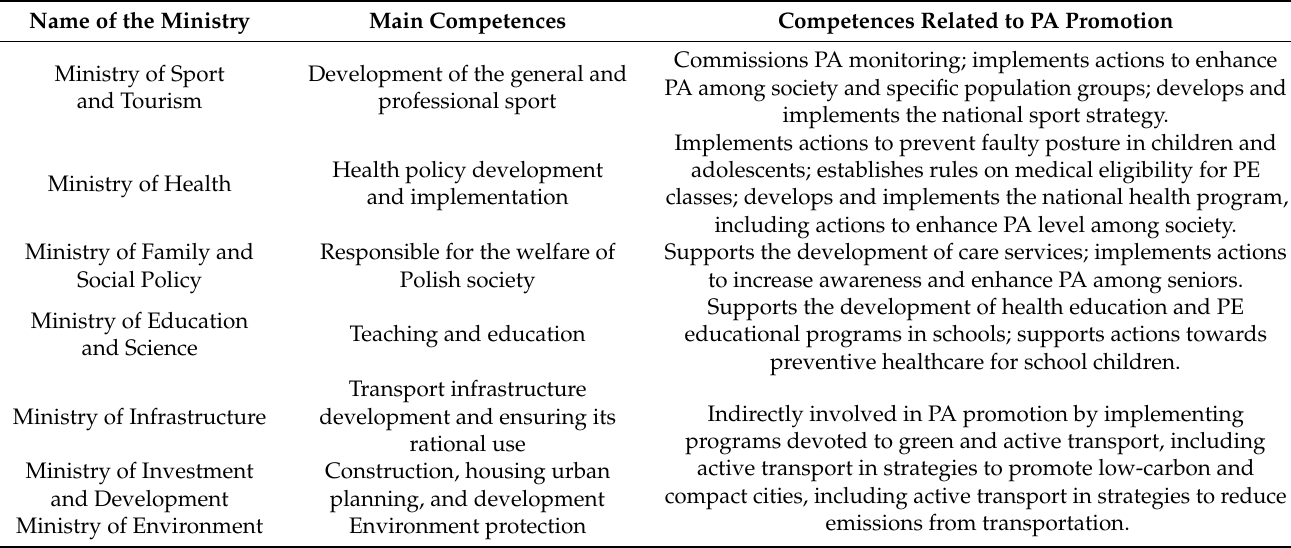
Table 2. The role of Polish ministries in PA